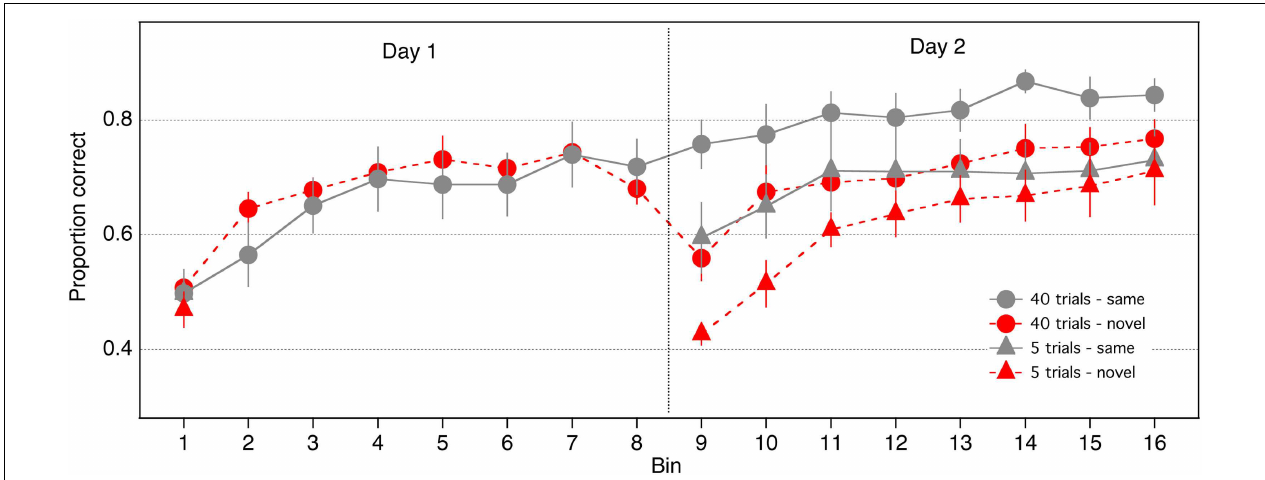
FIGURE 2 | Performance of the four groups on the face identification task over two consecutive days